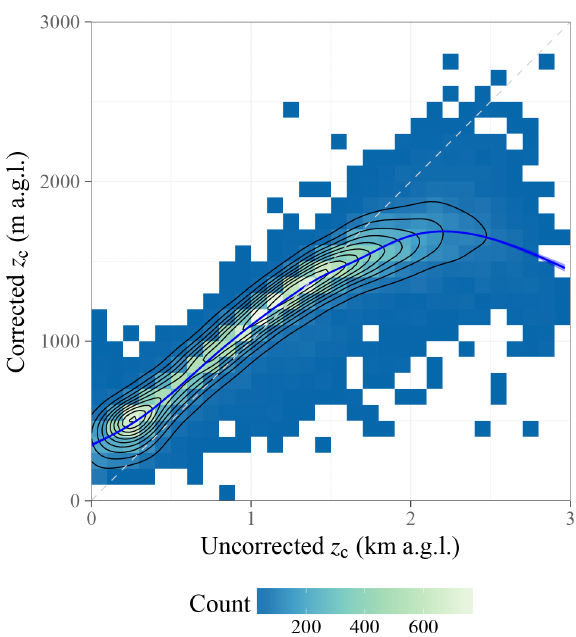
Figure 5. Density estimates of the projection of the SVM correc- tion function. The training dataset (ceilometer overpasses in 2008) is used as the ensemble for performing the